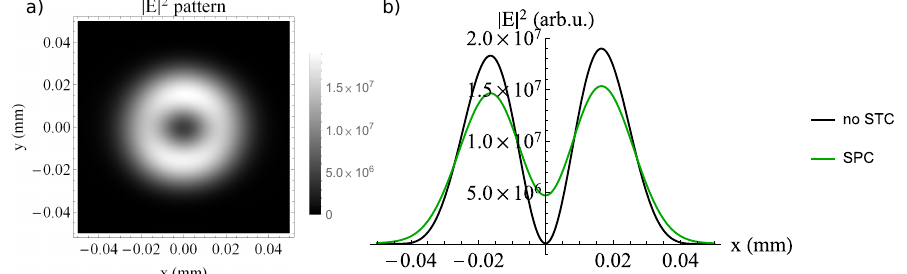
2 time integrated) of a laser field with SPC = Figure 7. ( a ) The fluence profile ( E | | in the focal region after being reflected by the helical mirror and focused by means of an f = 1500 mm mirror. ( b ) The fluence profile from ( a ) along the x axis, when y = 0 (green curve), compared with the fluence profile of the laser field without SPC (black